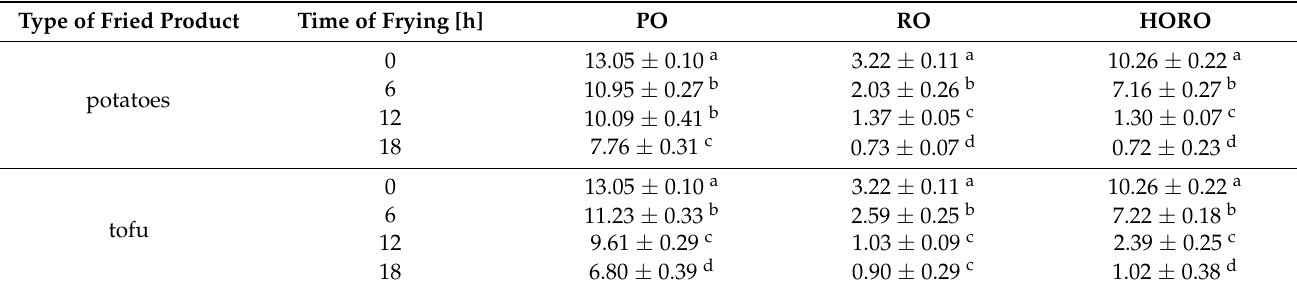
Table 2. Changes in the oxidation stability index (OSI) [h] in the Rancimat test of oils. Type of Fried Product